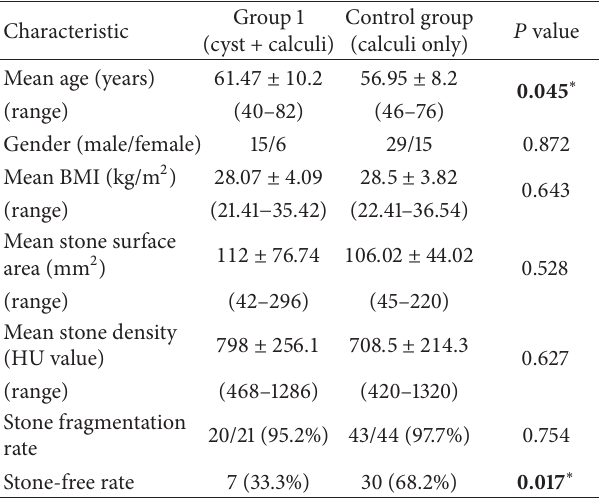
Table 1: Data of the